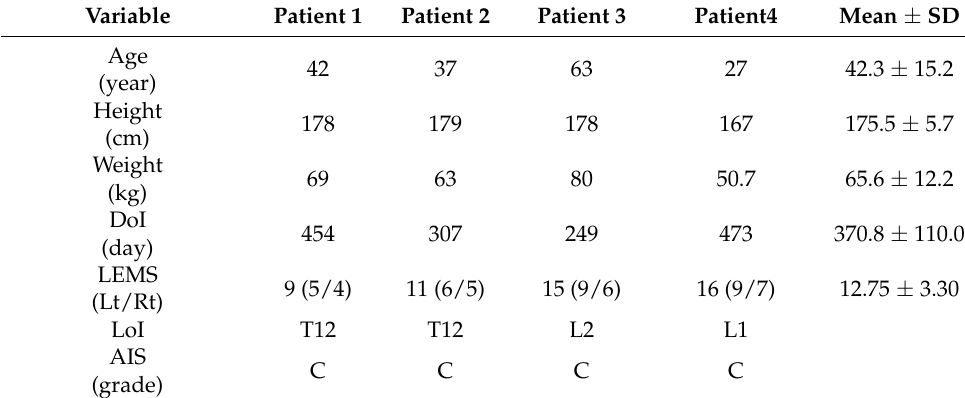
Table 1. Characteristics of the study subjects.